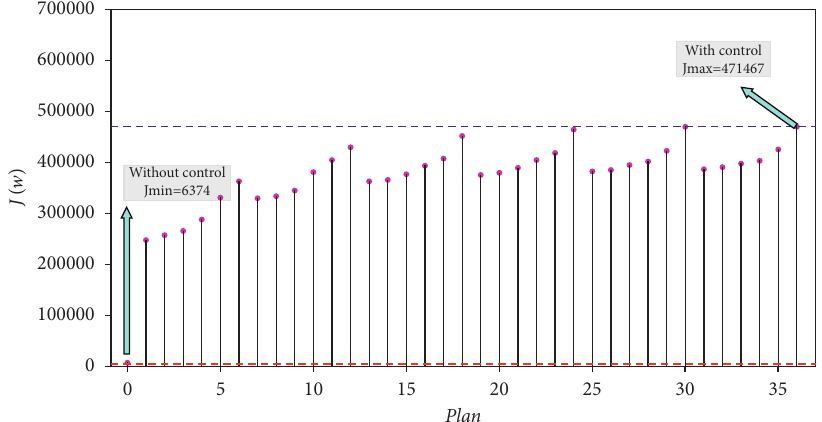
Figure 5: Economic benefits corresponding to different